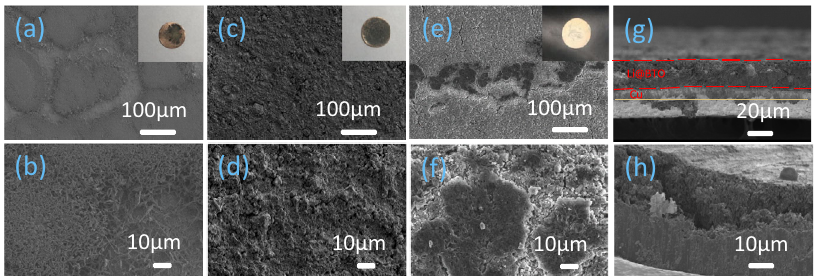
Fig. 7 Ex situ SEM postmortem morphological investigations of the bare Cu, AO and BTO scaffold after plating to 1 mA h cm − 2 at a current density of 2 mA cm − 2 . a , b Bare copper electrode and zoomed-in fi gure, c , d BTO scaffold and zoomed-in fi gure, e , f AO scaffold and zoomed-in fi gure, g , h cross- section of BTO and Cu electrode after depositing 1 mA h cm − 2 Li metal at a current density of 2 mA cm − 2 . Insets show the digital images of the complete electrodes.